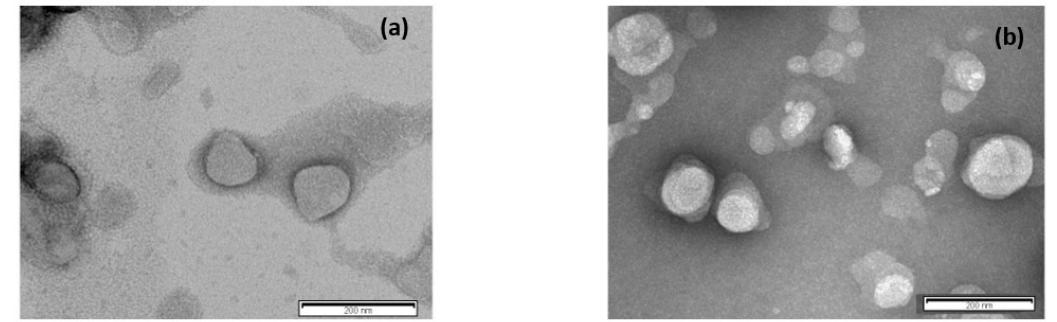
Figure 2. Transmission electron microscopy images of ( a ) blank pSLNs and ( b ) CUR-pSLNs. The scale bar represents 200 nm.